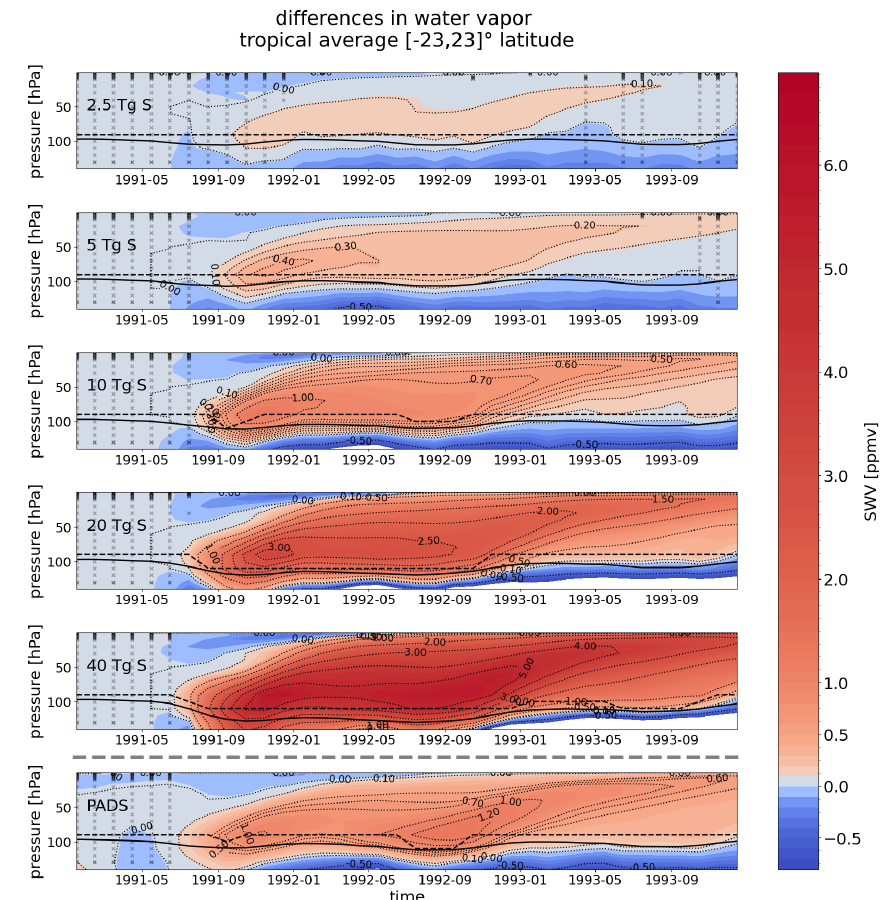
Figure 7. Tropical average in [− 23 , 23 ] ◦ latitude of WV anomalies above 140hPa for the sulfur injections of 2.5, 5, 10, 20 and 40Tg S as well as the PADS data set. The lowermost panel shows the MPI-GE historical simulations for Mt. Pinatubo using the PADS forcing data set discussed in Sect. 3.5. The WMO-tropopause pressure is indicated by a black line and the cold-point pressure is indicated by a dashed black line. Differences with respect to the 0Tg S control run are shown. In regions not covered by black crosses, statistically significant differences between water vapor values of the perturbed and unperturbed runs ( t test at p = 0 . 05) were found.